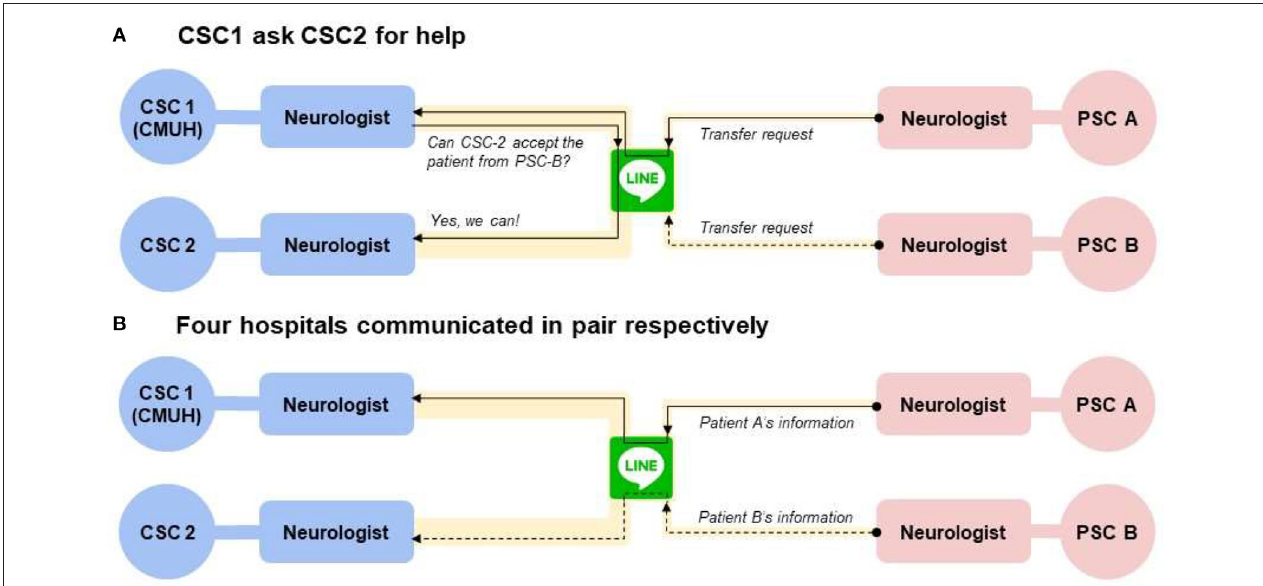
FIGURE 5 | The way of communication if there are simultaneous stoke activations in two different primary stroke centers. (A) Indicates the way CSC1 (our hospital) asked CSC2 for help. If CSC2 was available for thrombectomy, they would send the message on “Line” and both the CSC1 and PSC B could see it. Then the process moved to the (B) , that PSC A communicated with CSC1, and PSC B communicated with CSC2, respectively. CSC, comprehensive stroke center; ED, emergency department; PSC, primary stroke